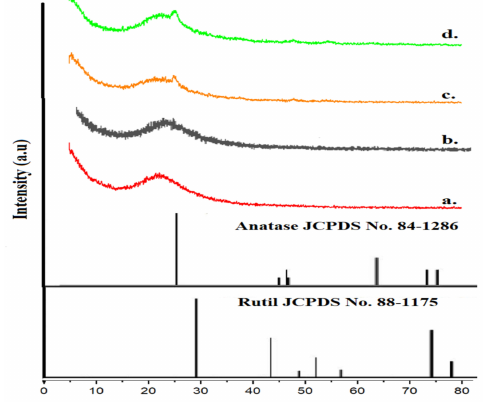
Figure 1. XRD diffractograms of a. SBA-15 and TiO 2 /SBA-15 with loading titania of b. 1%, c. 5%, and d. 10%.